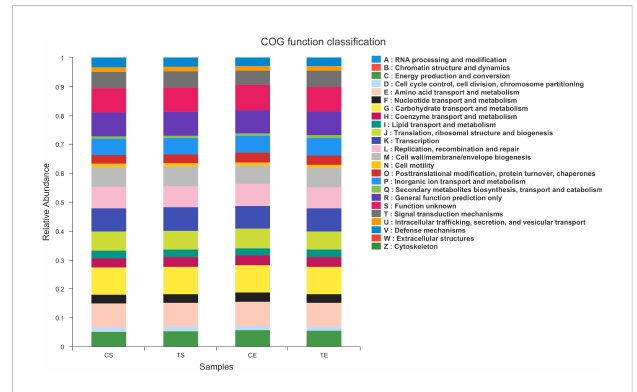
FIGURE 7 PICRUSt functional prediction was performed using EggNOG database, pathways related to type 2 diabetes were identi fi ed and